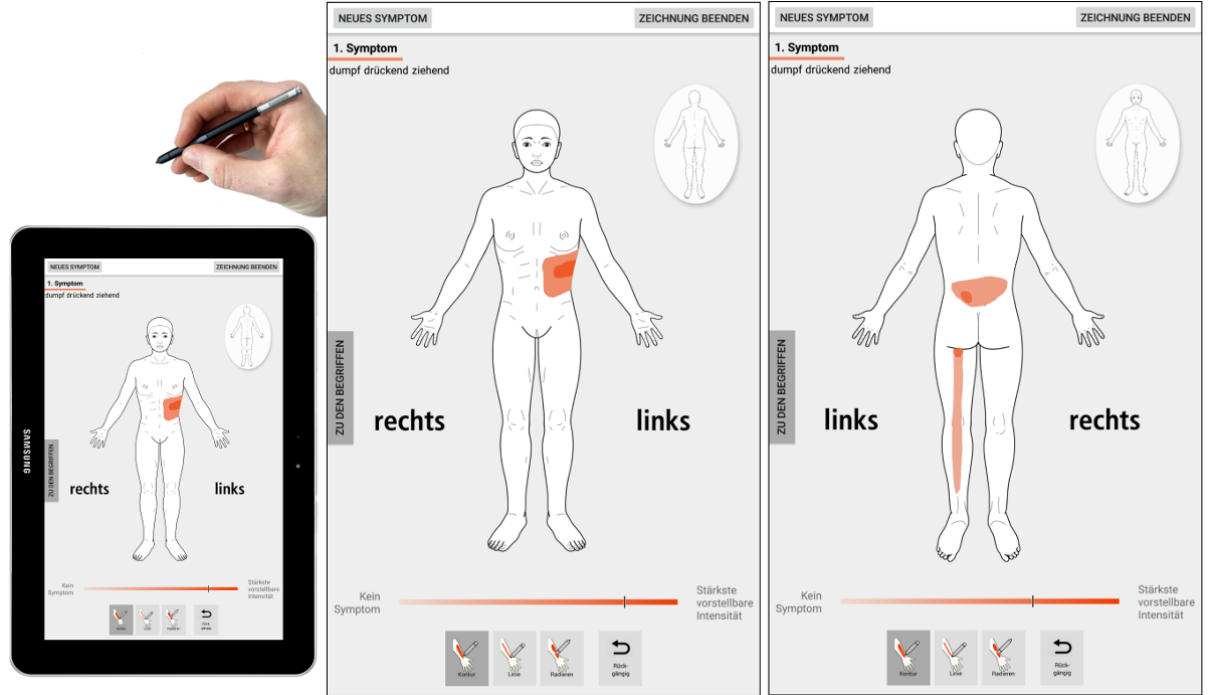
Figure 1. Graphical user interface of the SymptomMapper app that was used in our study. Its drawing module allows for quick and easy data entry without previous training, a crucial prerequisite when studying patients in acute pain situations. Sides are emphasized by the words left (“links”) and right (“rechts”). Doctors and patients used the same app for their pain